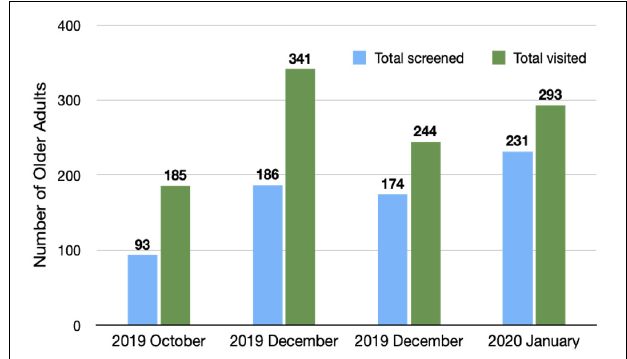
FIGURE 3 | Older adults visiting physician’s clinic and screened for memory problems: monthly aggregate of all participants